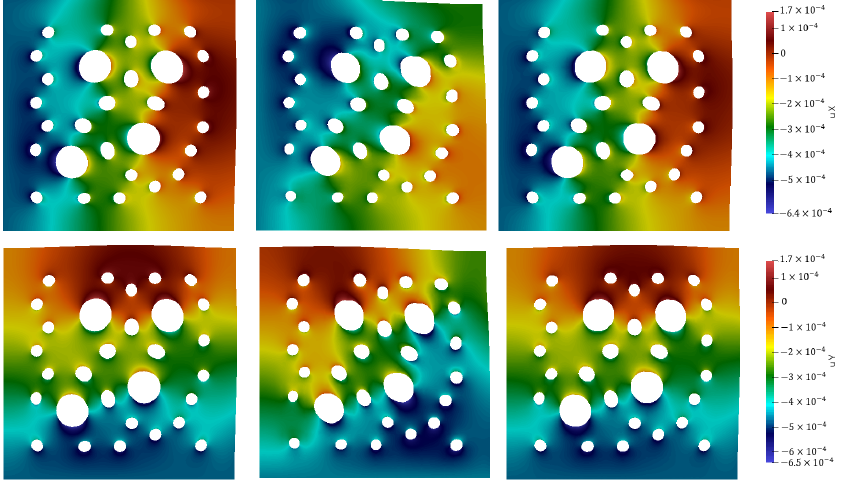
Figure 12. Elasticity problem. Case 2 (non-homogeneous boundary conditions). First row: displace- ment X-component. Second row: displacement Y-component. Left: Reference solution ( DOF h = 170,460). Center: Multiscale solution with 24 multiscale basis functions without perforation basis = 4900). Right: Multiscale solution with functions, e L 2 = 117.3 ( M g = M = 24, M p = 0, DOF u H 24 multiscale basis functions with perforation basis functions, e L 2 = 2.324 ( M g = M p = M = 24, = DOF u H